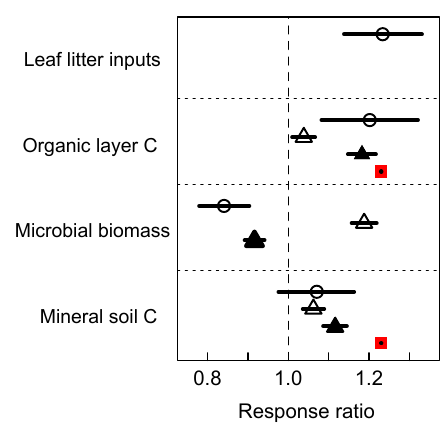
Figure 3. Observed and modeled C response ratio (treat- ment/control) to experimental N enrichment. Open circles show observed mean and 95% confidence interval of leaf litter inputs, organic layer C, microbial biomass, and mineral soil C (Liu and Greaver, 2010). Modeled results show the steady-state changes in pools following increases in leaf litter inputs projected by MIMICS (open triangles), MIMICS (with increasing MGE in response to N enrichment; filled triangles) and DAYCENT (filled squares; see also Supplementary Fig.